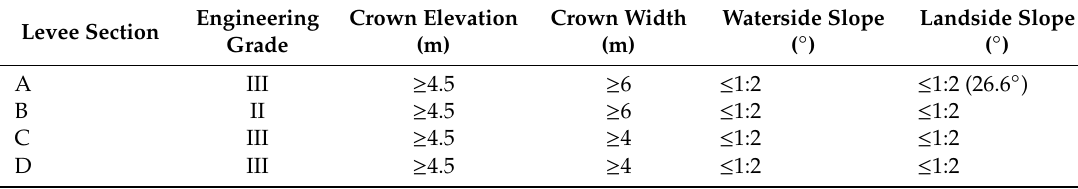
Table 1. The design criteria of geometric parameters for soil levees A to D. Levee